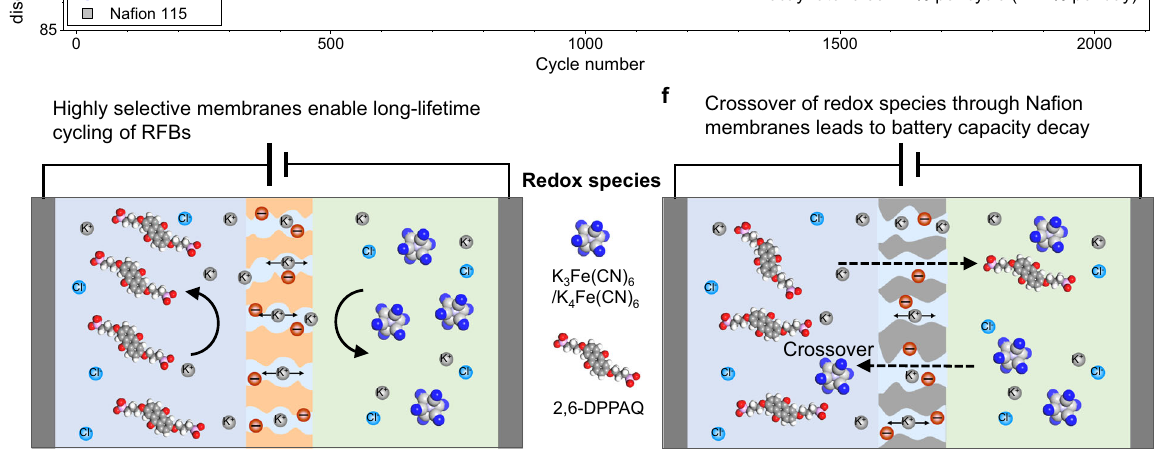
cycle) (Fig. 4d). An identical cell based on the less selective s PIM- SBF-1.67 membrane decays at a similar rate (0.00535% per cycle and 2.44% per day) to that of the cell with a Na fi on 115 membrane, which is consistent with the time-dependent crossover rates mea- sured from dialysis diffusion cells. It should be noted that these laboratory tests using low concentration of electrolyte resulted in multiple cycles each day, yet the results suggested that PIM membrane showed high rate of capacity retention due to minimal crossover over the testing period.